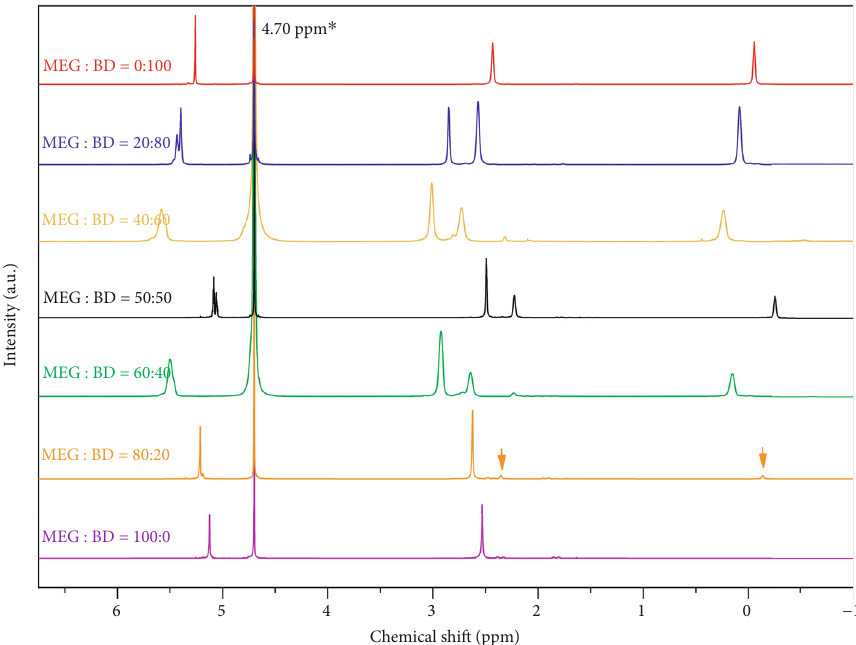
O and TFA-d1 were tagged “ ∗ ” at 4.7ppm). 2